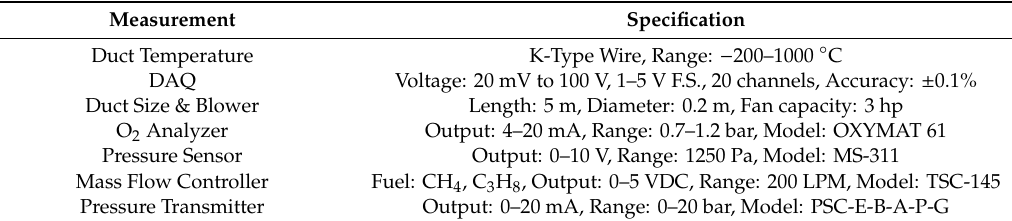
Figure 3. ( a ) Calibration results of heat release rate (HRR) using propane burner and ( b ) comparison of the theoretical and measured HRR. Table 2. Specification of the experiment apparatus of the cone-calorimeter.